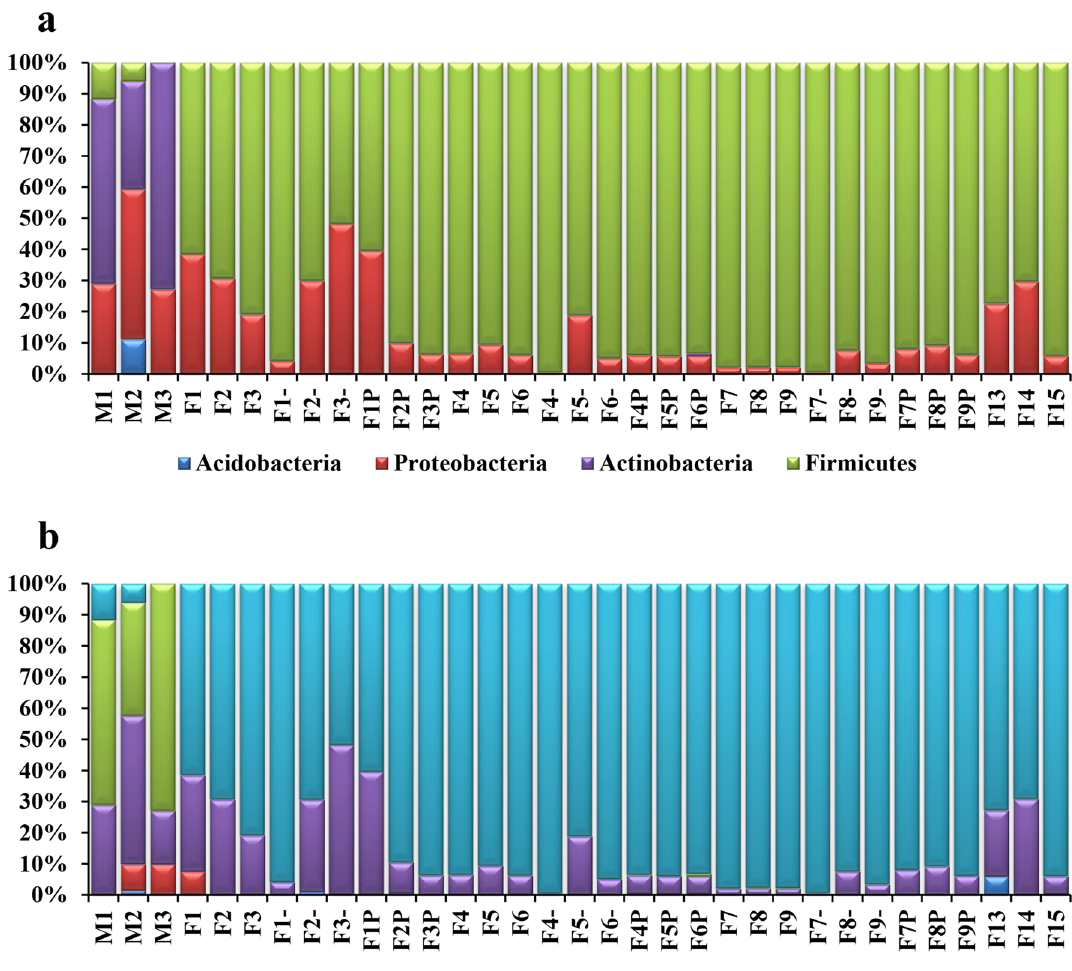
Figure 4. Bacterial diversity composition for the decomposed liver samples: ( a ) Phylum; ( b ) Class (sample symbols, except control: “–” liver inoculated with 10 2 S. enterica concentration; “P” liver inoculated with 10 4 S. enterica